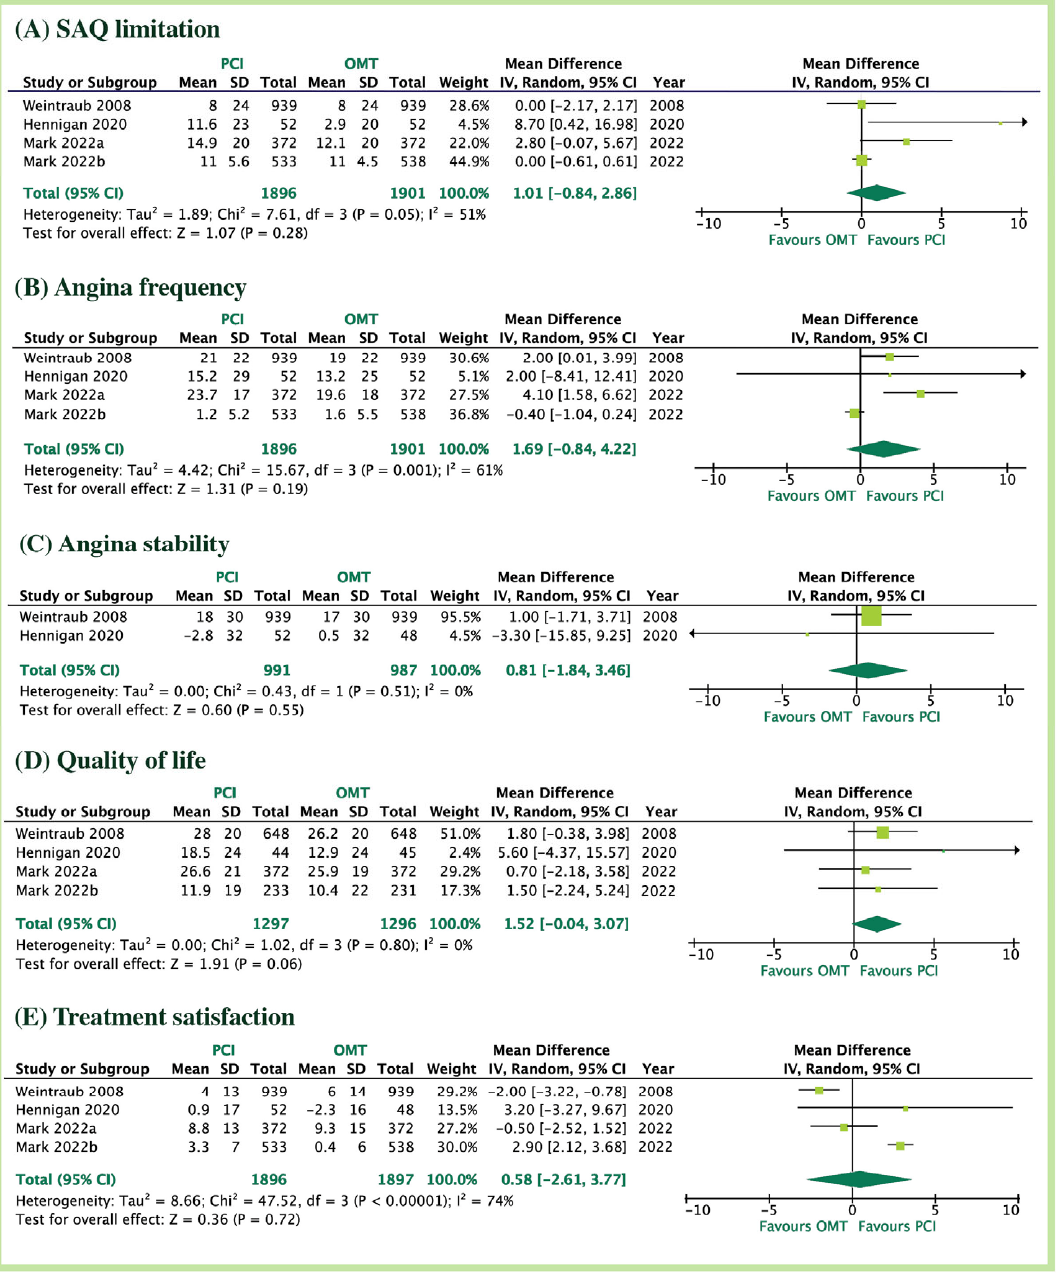
Figure 3. Quality of life with PCI versus OMT in long term; ( A ) physical limitation, ( B ) angina frequency, ( C ) angina stability, ( D ) quality of life, ( E ) treatment satisfaction. Abbreviations: PCI: percutaneous coronary intervention; OMT: optimal medical therapy; SAQ: Seattle Angina Questionnaire scores.